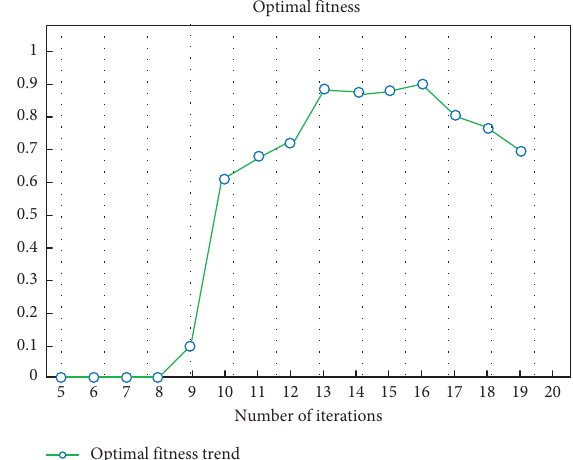
Figure 7: Variation of optimal ftness with the number of express and local trains.